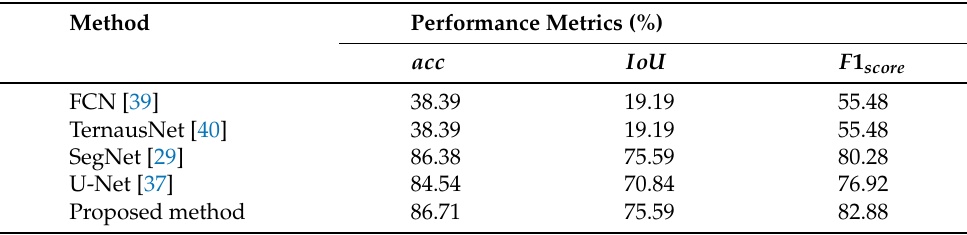
Table 8. Performance comparison with the other deep semantic segmentation